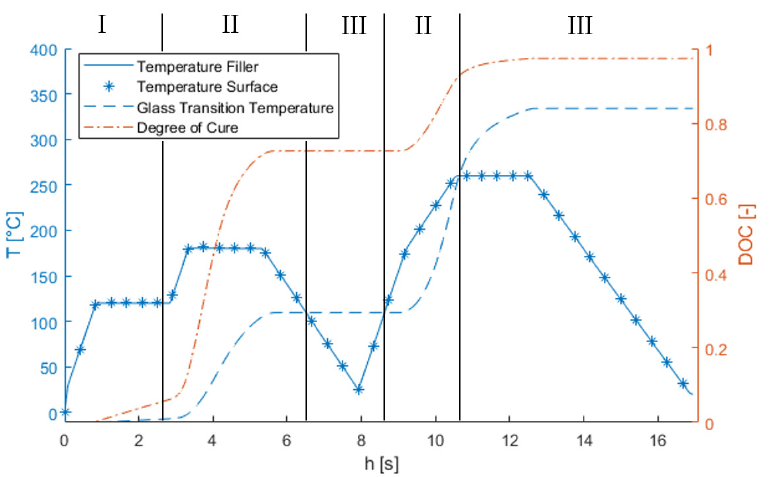
Figure 8. Geometric model and temperature distribution at the end of the process. Visible residual heat in regions with increased part thickness. I–III denote the state of the material in the liquid, rubbery, and solid phase, respectively.